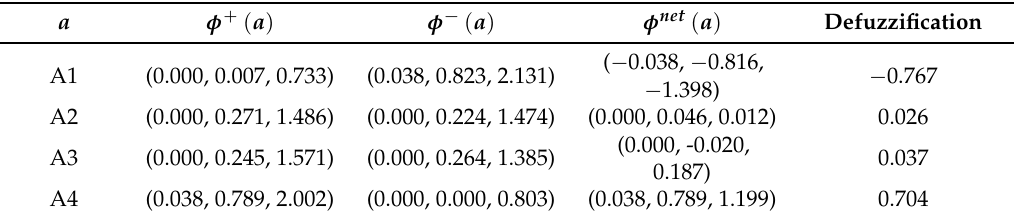
Table 14. The positive leaving flow and the negative entering flow.